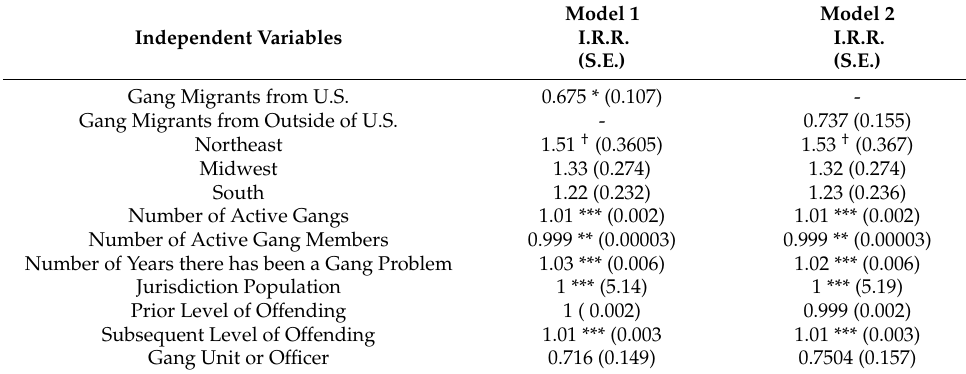
Table 3. Gang Migrants from Inside/Outside the United States and Gang-Related Homicides (n = 781).